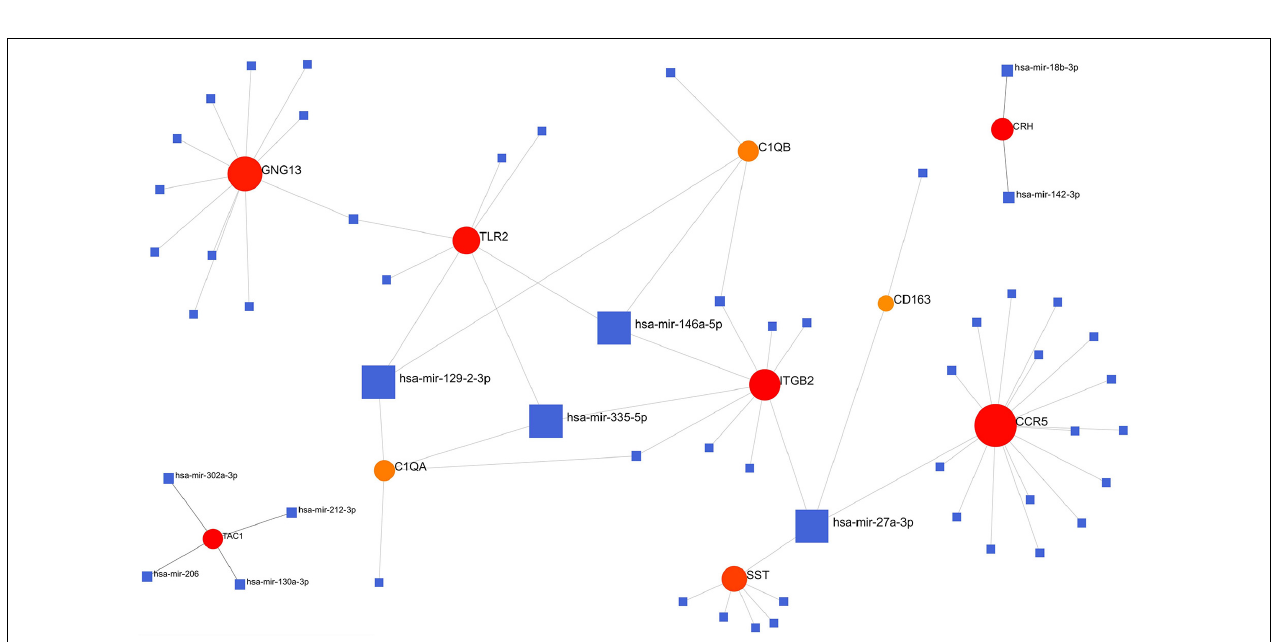
FIGURE 7 | Hub gene–miRNA interaction network. Medium confidence score was used to construct the network.